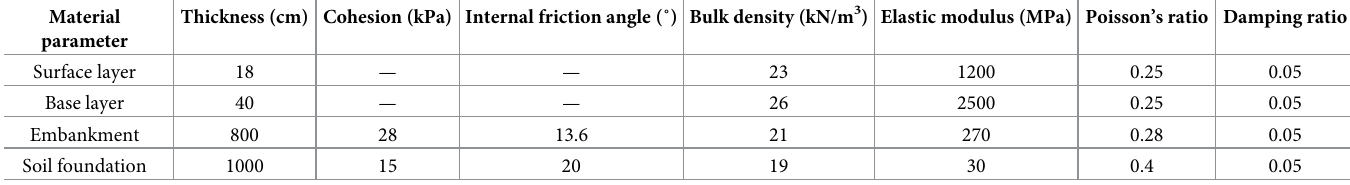
Table 3. Calculation parameters of embankment and pavement structure. Material